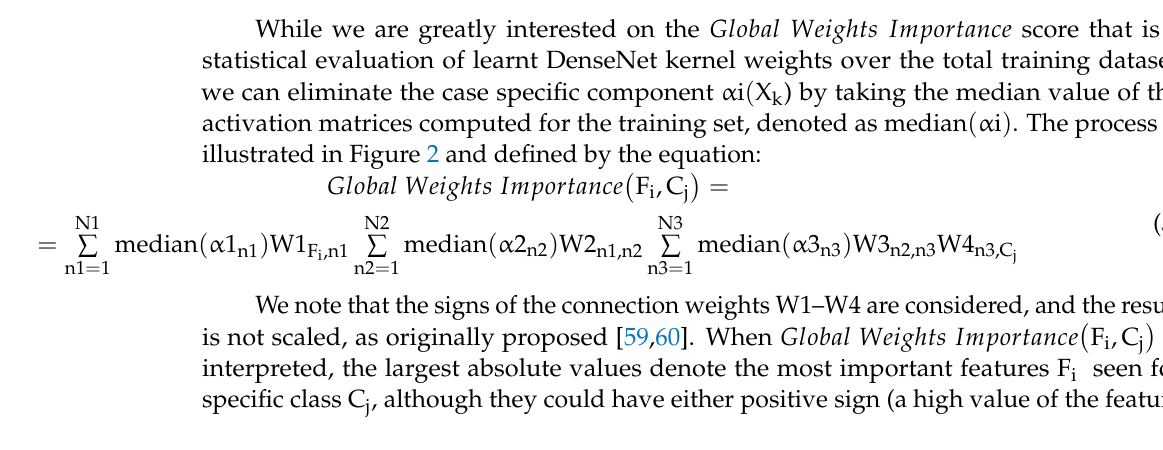
Figure 2. Illustration of the process for computation of Case Weights Importance and Global Weights Importance based on an example neurons weights matrix Wi ∈ R [ 1 × 40 ] and neurons activation state matrix α i ( X k ) ∈ R [ 11 × 40 ]